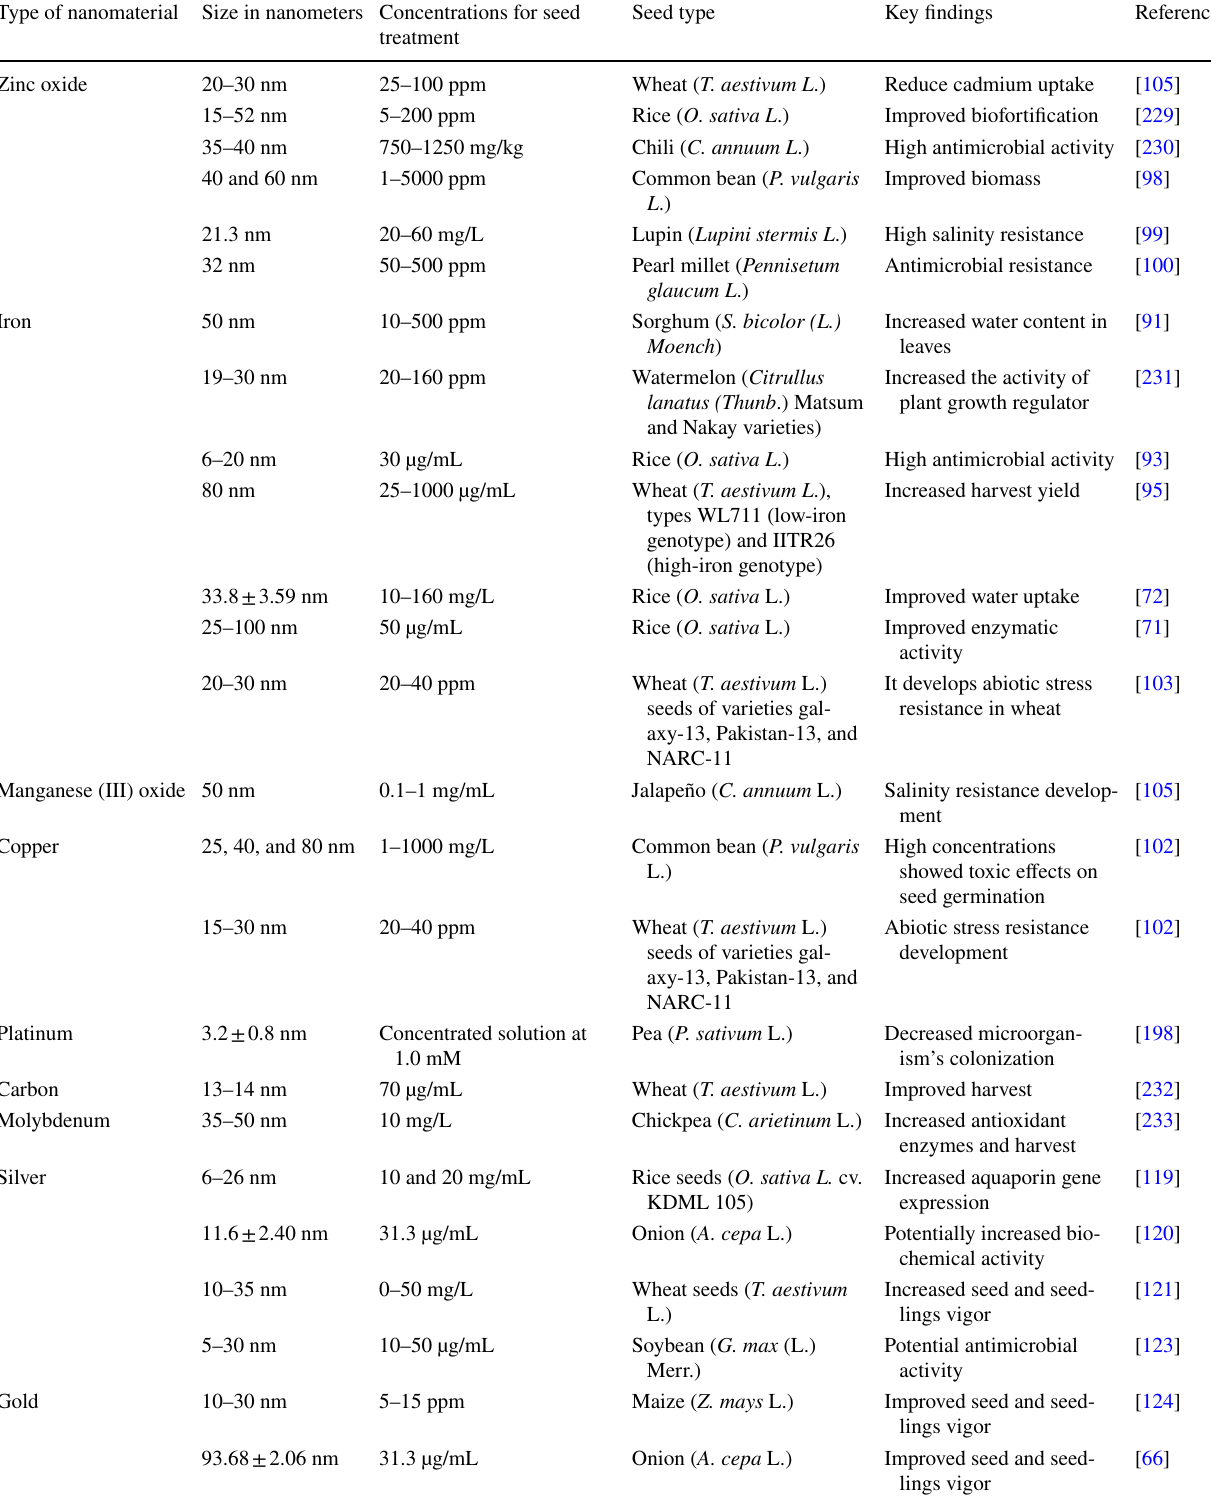
Table 2 An overview of the nanoparticle systems used in seed priming and coating, their characteristics, and their main effects on different seed species Type of nanomaterial Size in nanometers Concentrations for seed